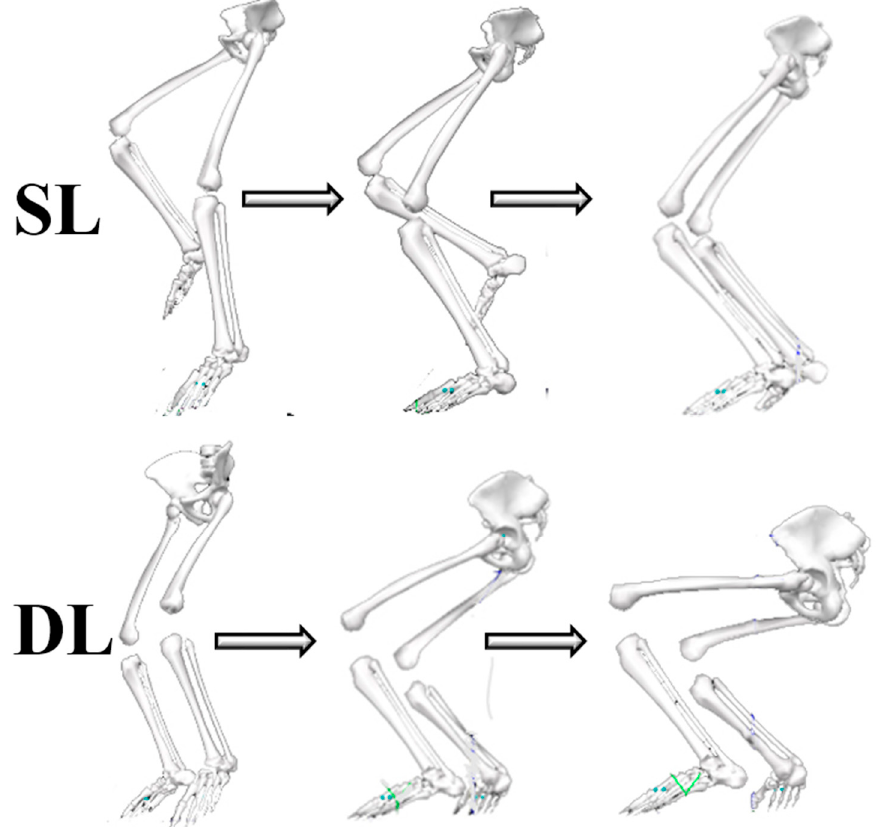
Figure 3. The process of single leg landing (SL) and double-leg landing (DL) following a